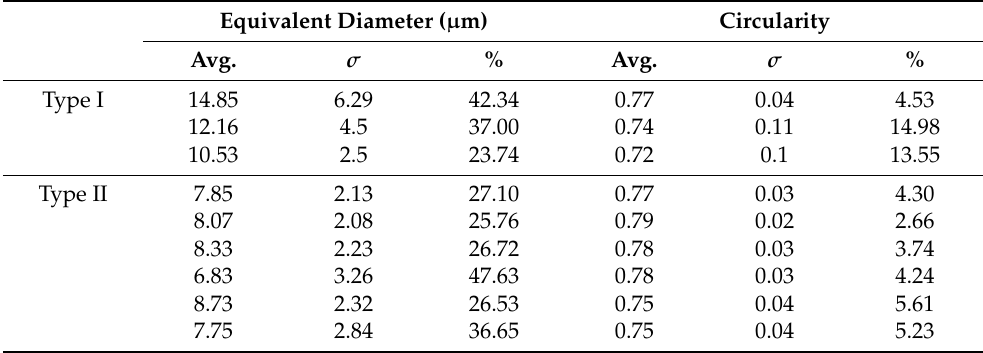
Table 2. Average, standard deviation ( σ ), and percent variability ( σ as %) of equivalent diameter and circularity from the microscopic imaging analysis data of particles in water